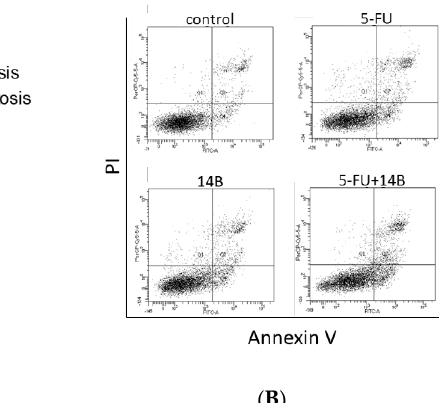
Figure 6. Pro-apoptotic activity of 5-FU, 14B, and CX-4945 on MDA-MB-231, used separately and in combinations. The data were determined by FACSCanto II flow cytometer (fluorescence-activated cell sorter) after 72 h treatment. Cells were stained with annexin V-FITC and PI (propidium iodide). ( A ) Mean and standard deviation (SD) of necrosis, and early and late apoptosis as percent from three independent experiments each; ( B ) representative cytograms for control (0.5% DMSO, dimethyl sulfoxide), 15 µM 5-FU, 2 µM 14B, and a combination of 5-FU and 14B. Additionally, the relative expression of apoptotic markers, i.e., cleaved PARP1 (c-PARP1), caspase 7, and apoptosis inducing factor (AIF), were investigated by western blot analysis. Interestingly, we detected a statistically relevant increase of c-PARP1 in the cells treated with both the combinations compared with the cells treated with 5-FU alone (2.8 after 48 h), with the highest relative expression values of 4.8 and 7.1 for 5-FU + 14B and 5-FU + CX-4945, respectively, after 48 h of treatment (Figure 7).